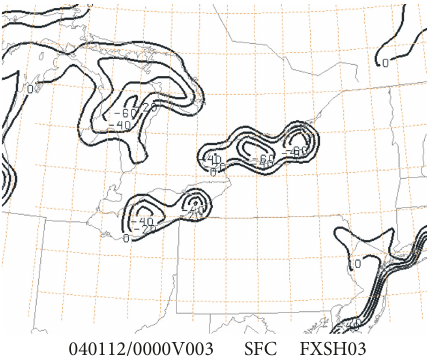
Figure 11: Sensible heat flux (solid, Wm −2 ) in the NARR at 0300 UTC 12 January 2004.